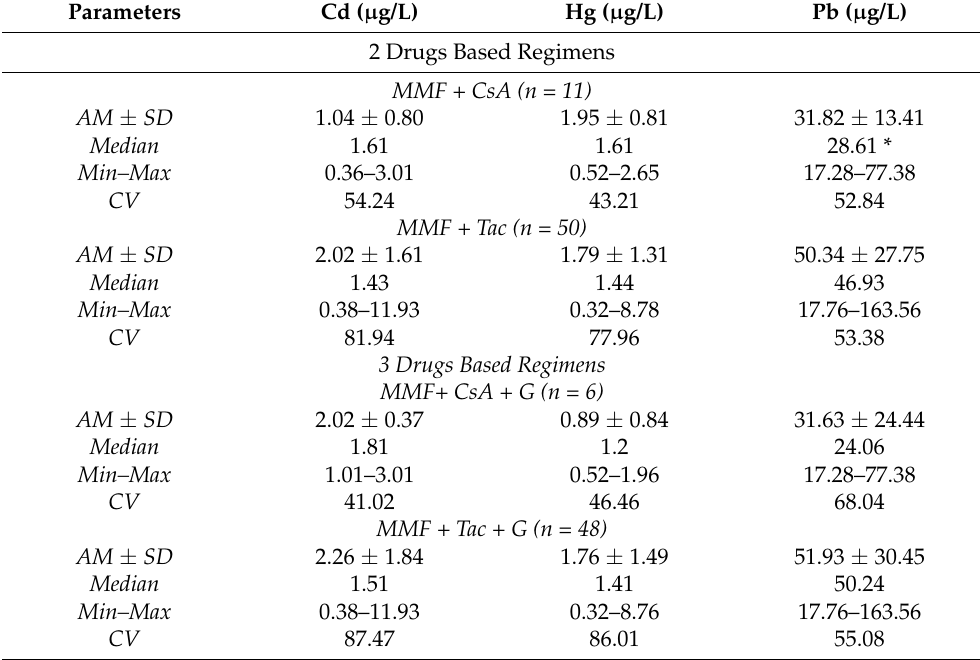
Table 3. Cadmium, mercury and lead concentrations in erythrocytes of renal transplant recipients with division on immunosuppressive regimens (MMF: mycophenolate mofetil; CsA: cyclosporine A; Tac: tacrolimus; G: glucocorticosteroid; AM: arithmetic mean; SD: standard deviation; Min-Max: minimum and maximum values; CV: coefficient of variation in %; * p < 0.05, statistically significant difference vs. MMF + Tac).